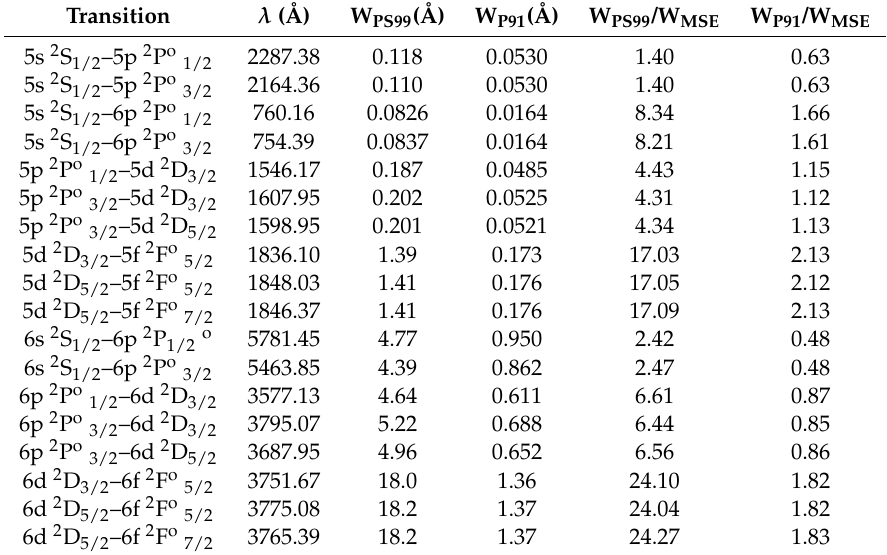
Table 2. Estimated Stark widths for 18 spectral lines of Zr IV according to Puri´c and Š´cepanovi´c, 1999 (W PS99 ) and Puri´c et al., 1991 (W P91 ) for a temperature of T = 10,000 K and electron density of N = 10 23 m − 3 . Estimated Stark widths are compared with MSE calculated Stark widths W MSE